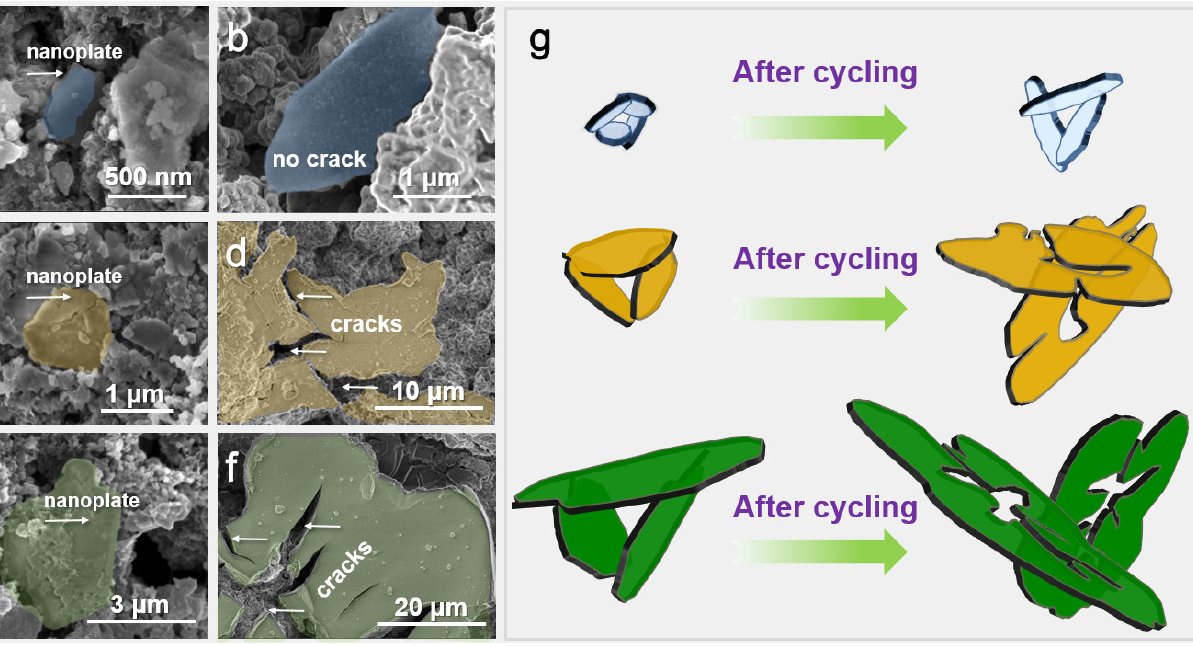
Figure 6. SEM images of ( a , b ) (Ni,Co,Mn)Fe 2 O 4 , ( c , d ) Fe 3 O 4 /M n3 O 4 and ( e , f ) Fe 3 O 4 electrodes before ( a , c , e ) and after ( b , d , f ) cycling at 100 mA g − 1 for 200 cycles. ( g ) Schematic diagram of the structural changes in the corresponding electrodes before and after cycling.